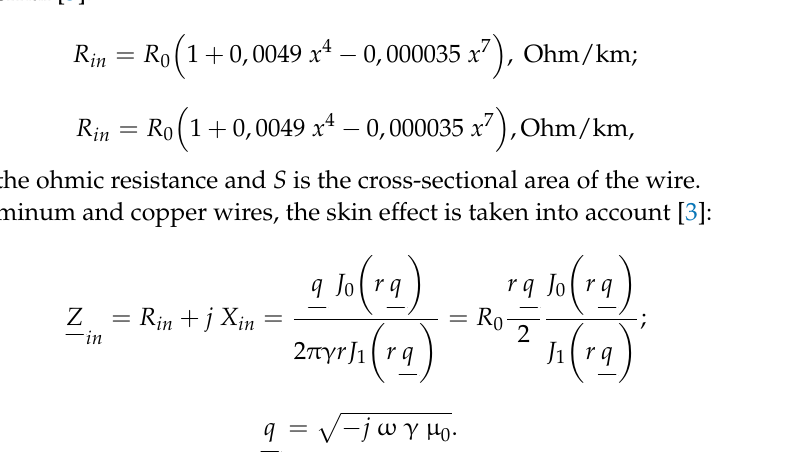
Figure 5. Original circuit of the power transmission line. Phase coordinates are the most natural description of three-phase power systems.